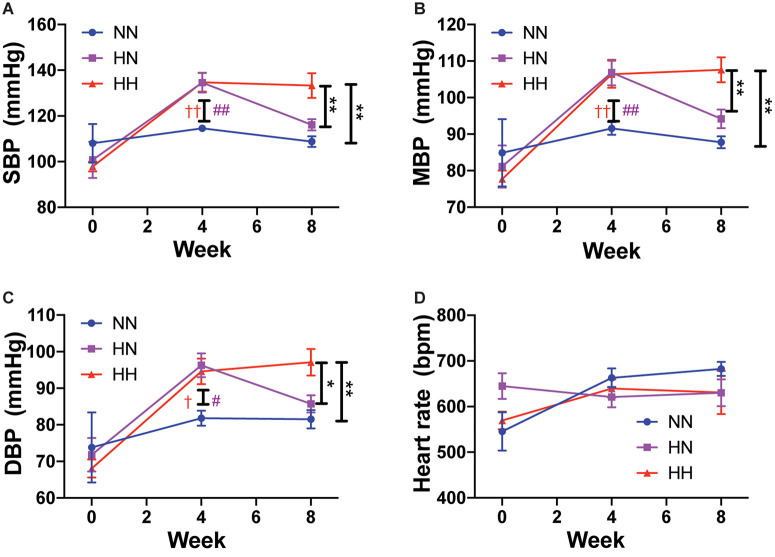
Angiotensin II infusion increases blood pressure but does not affect heart rate. (A) Systolic blood pressure (SBP), (B) mean blood pressure (MBP), (C) diastolic blood pressure (DBP), and (D) heart rate in HH, HN, and NN cohorts over the course of the experiment. n = 10 per group. At 8 weeks: ∗p < 0.05, ∗∗p < 0.01 by repeated measures 2-way ANOVA with Bonferroni post hoc analysis. At 4 weeks: #p < 0.05, ##p < 0.01 for HN vs. NN and †p < 0.05, ††p < 0.01 for HH vs. NN by repeated measures 2-way ANOVA with Bonferroni post hoc analysis.